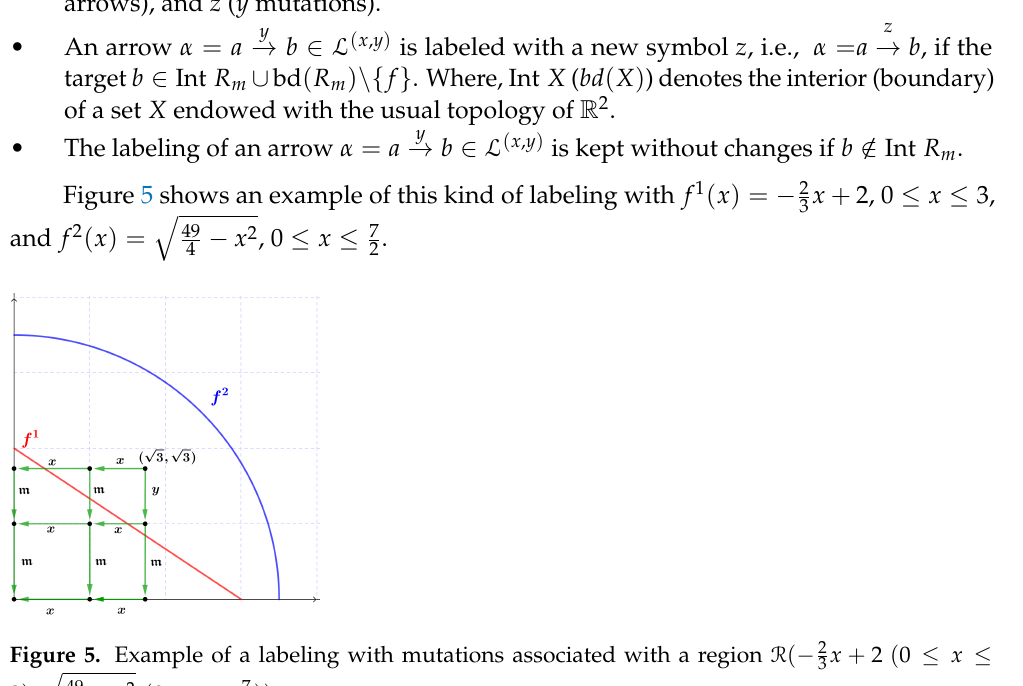
) and mutation ( R m ) regions. r